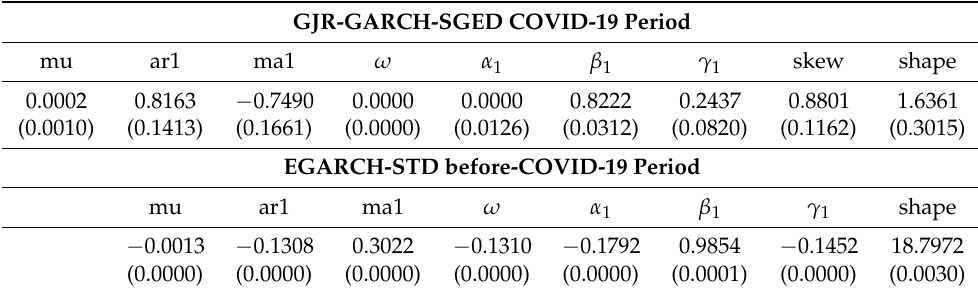
Table 3. Best-fitted GARCH models parameters of PSX-100 closed-returns for two periods. GJR-GARCH-SGED COVID-19